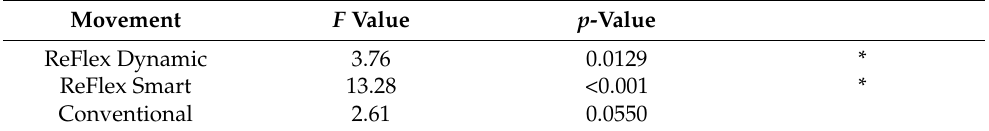
Table 3. Comparison between different types of files with the same movement (* = p value < 0.05).